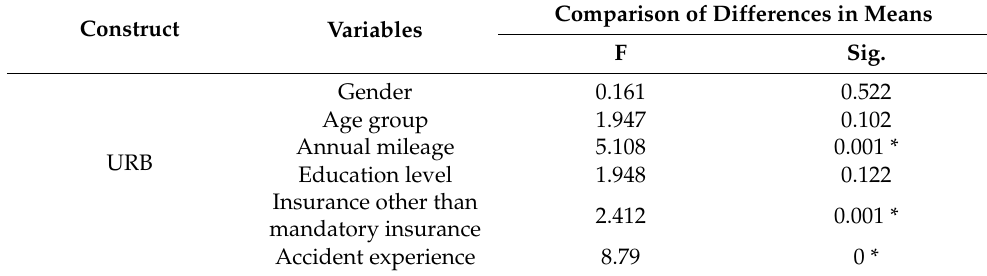
Table 8. Results of one-way